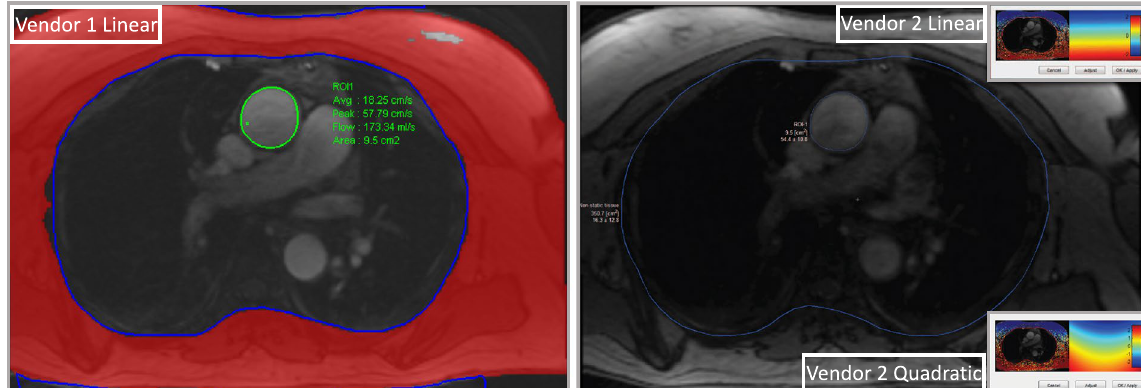
Figure 1. Stationary tissue background correction in Vendor 1 and Vendor 2. Non-static tissue was excluded by regions of interest in blue. The amount of static tissue was maximized by increasing the phase deviation threshold, which is shown in Vendor 1 (to the left) in red. In Vendor 2, linear correction is shown in the smaller window in the top right corner, and quadratic correction is shown in the smaller window in the bottom right